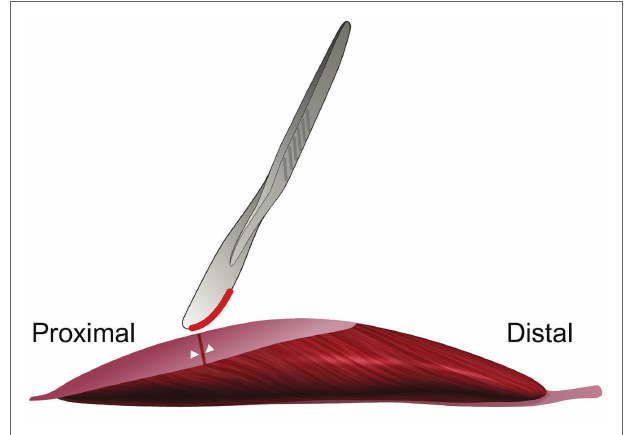
FIGURE 1 | Schematic figure illustrating the aponeurotomy intervention of the proximal gastrocnemius medialis (GM) aponeurosis. The proximal aponeurosis of the GM in the right limb was cut at its middle perpendicular to its length. The white markers indicate the locations where the 0000 silk sutures were placed. Note that the GM muscle is illustrated free from other muscles and structures. In vivo , during the intervention, surrounding muscles are